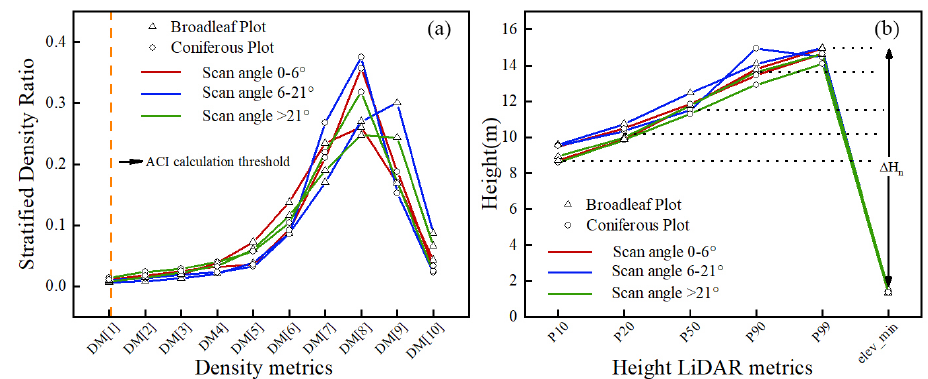
Figure 11. Statistics for the LiDAR-based vertical structure variables: density metrics ( a ) and height LiDAR metric ( b ). The Δ Hn values are the vegetation heights, representing the value at each height percentile relative to that at the lowest height, or the vegetation range that can be covered by the laser point cloud in the vertical direction.